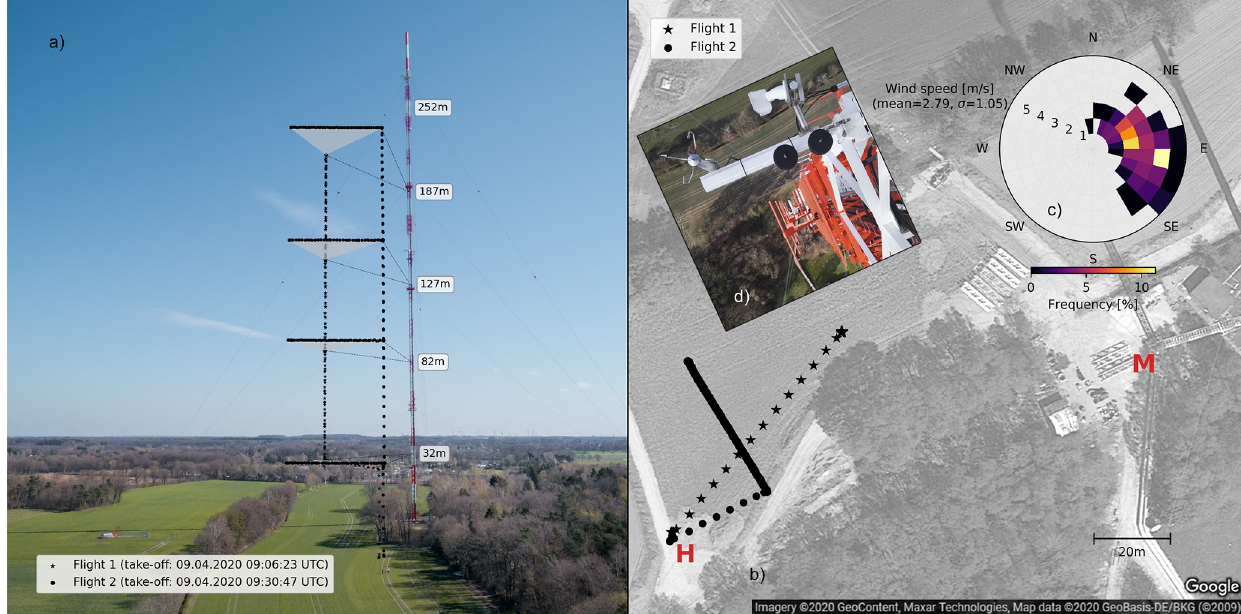
Figure 5. Overview of the validation flights on 9 April 2020 at the ICOS atmospheric station Steinkimmen (STE) near Bremen hosted on a broadcasting tower of the NDR. (a) Positions of measurements of both flights projected onto an aerial photograph. (b) Top view of the measurement site including launch point (H), position of measurements (stars and circles), and position of the lattice tower (M). (c) Histogram of wind speed and direction. (d) ICOS instruments and orientation of the lattice tower; image courtesy of the German meteorological service